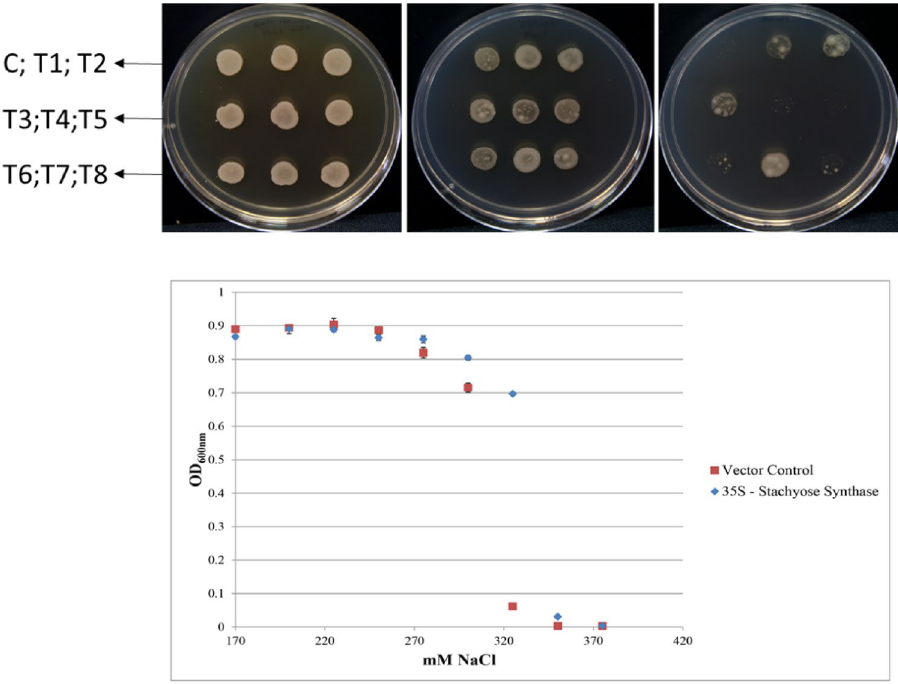
Figure 1. FOX screening of Stachyose Synthase genes from Tripogon loliiformis cDNA library in 320 mM; 345 mM and 370 Mm NaCl respectively at 48 h. Plates contain C:Control; T1–T7 Tripogon loliiformis stachyose synthase. Graph shows T7 (TlStach) growth in LB broth supplemented with NaCl. Optical density of bacterial growth presented as means at p < 0.05 using Minitab software version 17 (https:// www. minit ab. com/ en- us/ produ cts/ minit ab/ free- trial/).